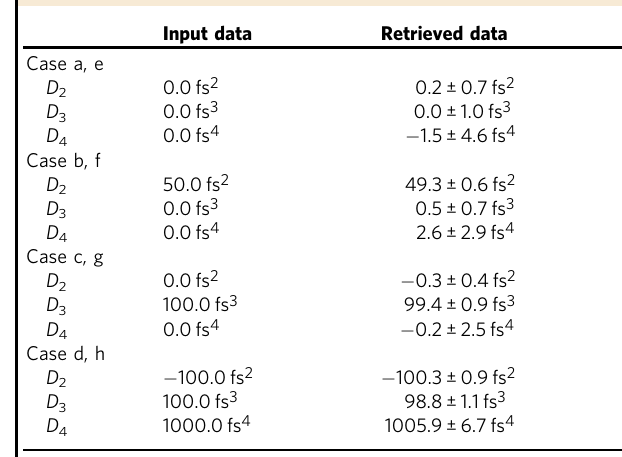
Fig. 2 Numerical simulation of the effect of plasma gating. a – d Calculated neon absorbance spectra for 50-fs SASE pulses, having averaged over 200 single SASE-FEL pulses per time-delay setting. Simulation for different values of D n for n ≥ 2 with increasing order from left to right. e – h The red solid curve represents the dispersion function [ τ ( ω ), see Eq. (1)], which was used as input for the calculation of the absorbance and corresponding output data (blue dots) are extracted by fi tting a step function to the calculation results. The dashed vertical line indicates the 50-eV center photon energy (bandwidth around 1 eV). In the trivial case of no dispersion, i.e., D n = 0 for n ≥ 2, displayed in a , e , the absorption spectrum is governed by a time-dependent “ ramp ” signal located at around τ = 0 (pump-probe pulse overlap) and is constant over ω . The case of a second-order (group-delay) dispersion of D 2 = 50 fs 2 , displayed in b , f , yields a steep linear dependence of τ ( ω ). c , g Parabola-shaped signal trace obtained through imposing a third-order dispersion of D 3 = 100 fs 3 , and, displayed in d , h , the “ wavy ” -shaped signal trace obtained through a dominant fourth-order dispersion (combined dispersion coef fi cients D 2 = − 100 fs 2 , D = 100 fs 3 and D = 1000 fs 4 ). See Table 1 for quantitative analysis of numerical input and retrieved data. 3 4 Table 1 Numerical input and retrieved data for different con fi gurations of spectral phase to quantify the retrieval accuracy.